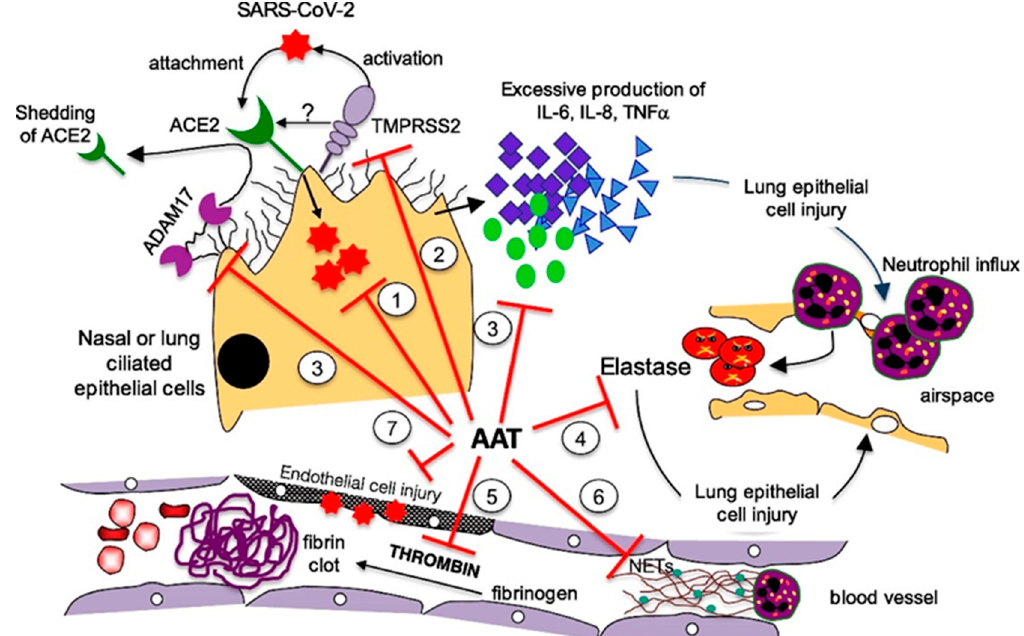
Figure 1. Shared pathogenic pathways between AATD and SARS-CoV-2 infection (1 = host immune dysregulation; 2 = increased activation of TMPRSS2; 3 = increased neutrophils mobilization; 4 = irrelevant inhibition of NE activity; 5 = reduced clotting antagonization; 6 = elevated NETs formation; 7 = increased endothelial cell apoptosis). (ACE2 = angiotensin-converting enzyme 2; IL-6 = interleukin 6; IL-8 = interleukin 8; NETs = neutrophil extracellular traps; TMPRSS2 = transmembrane serine protease 2; TNF- α = tumor necrosis factor-alpha) [33].